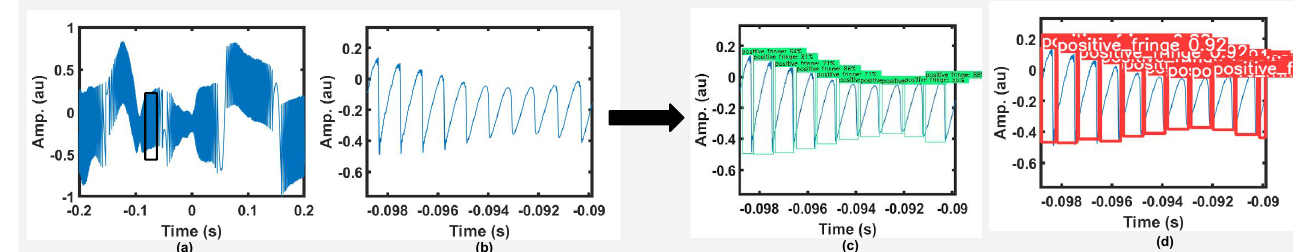
Figure 9. Fringe labeling applied on a speckle affected experimental SMI signal ( a ), ( b ) an enlarged view of a segment of this SMI signal, ( c ) FD results by the trained EfficientDet model, and ( d ) by the trained Yolov5